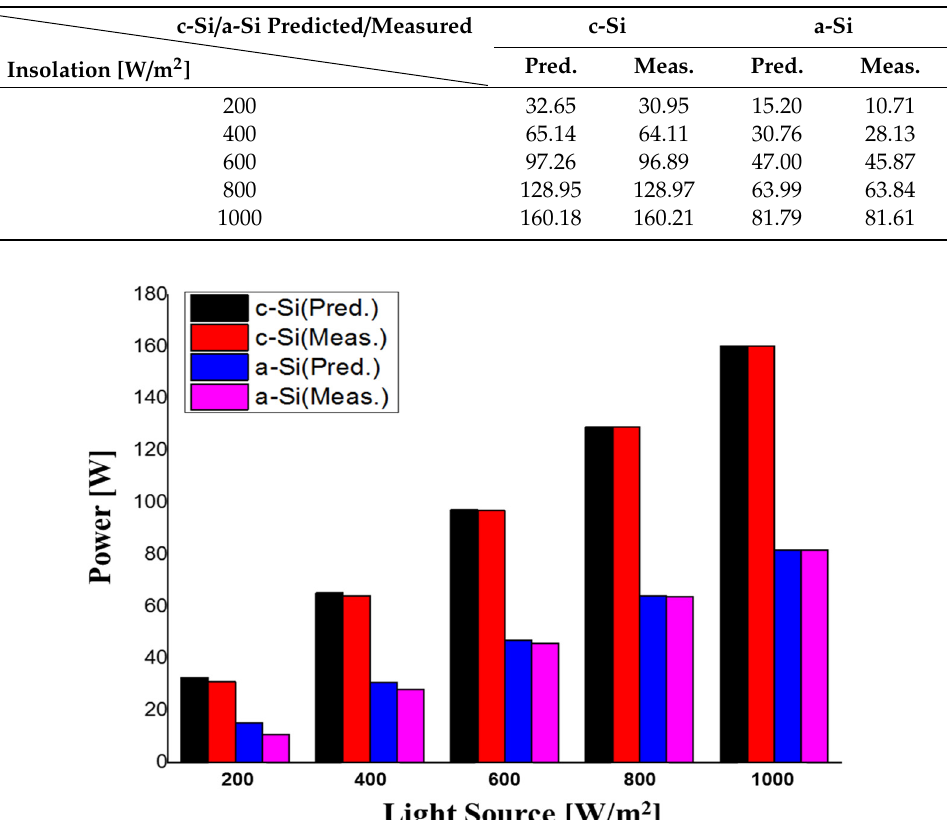
Table 5. Comparison of the generated power of the PV modules between the laboratory test (measured) and the Sandia model (predicted).